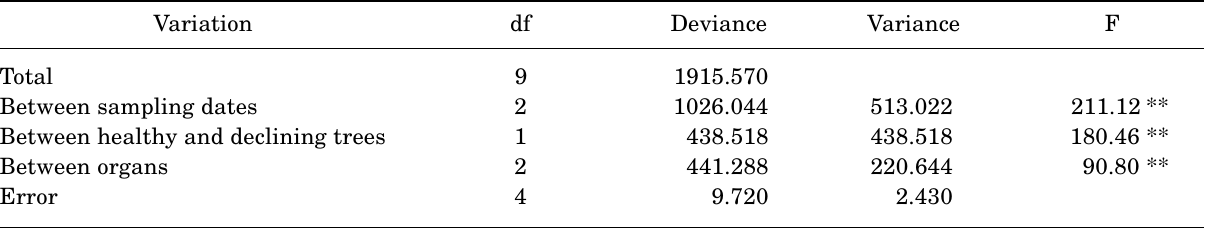
Table 3. Analysis of variance on the isolation frequency as a function of various parameters (ARCSIN